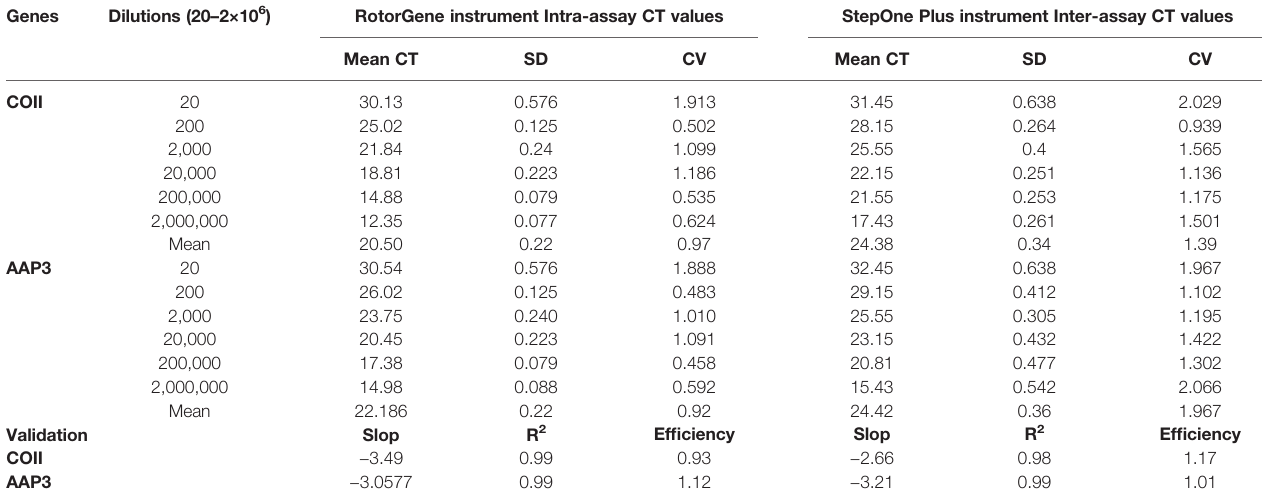
TABLE 1 | Comparison and validation of repeatability results of two COII and AAP3 genes. Genes Dilutions (20 – 2×10 6